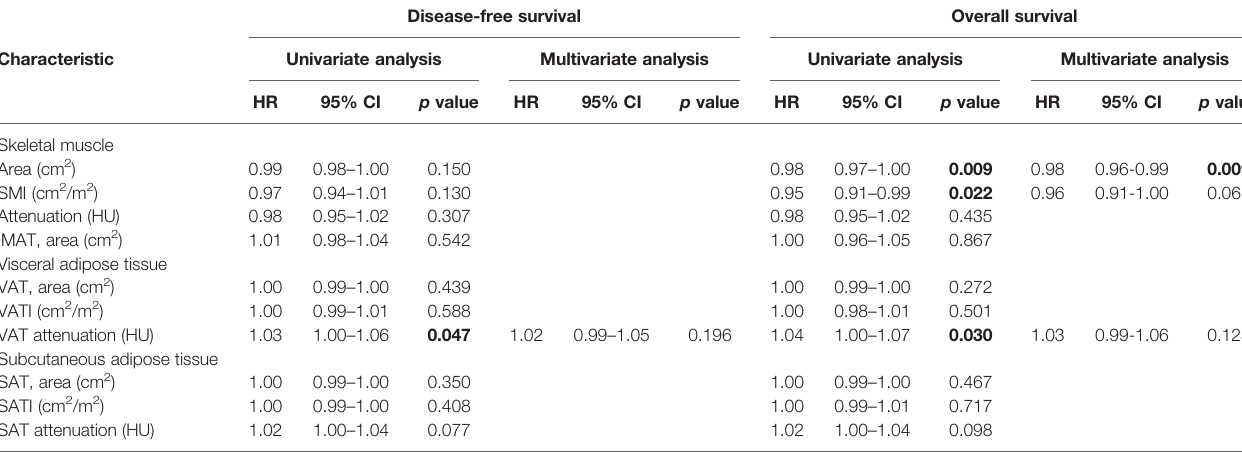
TABLE 3 | Univariate and multivariate COX regression analyses of body composition features of rectal cancer